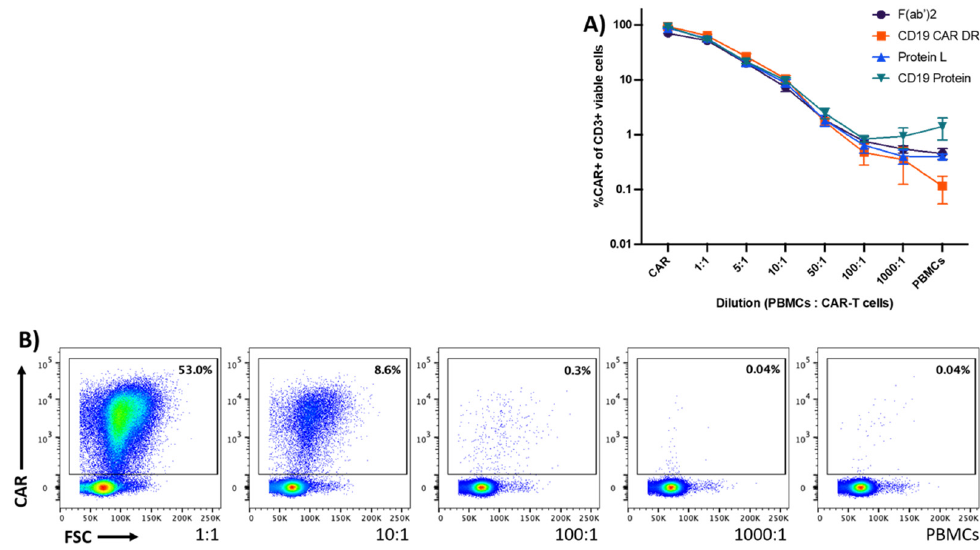
Figure 3. Sensitivity of the detection reagents to detect CD19-specific CAR-T cells in PBMCs. Graph ( A ) shows CD19-specific CAR-T cells that were serially diluted in PBMCs of the same HD at six different dilutions (1:1 to 1:1000). The graph displays the mean values ± standard error of mean of CAR-T cells to PBMCs from four HDs. ( B ) The dot plots display representative data obtained from one out of four different HDs. Data are representative of four different HDs acquired in one experiment.